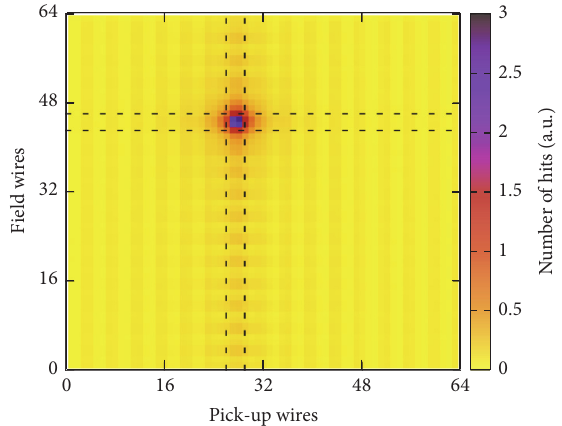
Figure 11: Distribution of all hits identified in the detector layer irradiated with the source. The local rate increase is apparent relative to the otherwise homogeneous distribution of cosmic-induced hits.